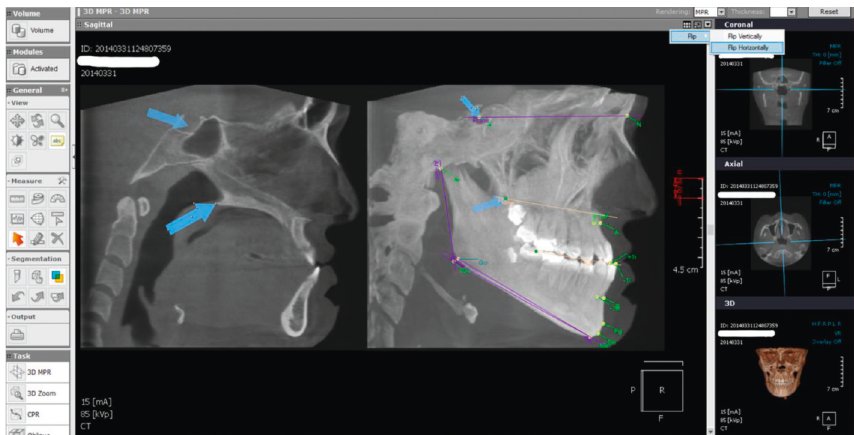
Figure 1: Left image: Two arrows were used to point out the exact places of points S (Sella) and PNS (Posterior Nasal Spine) and these arrows were preserved during slice manipulation. Right image: The thickness of the sagittal view was increased to 100 mm to get a CBCT- derived cephalometric image while keeping the arrows stable in their places in order to help in identifying points S and PNS accurately.